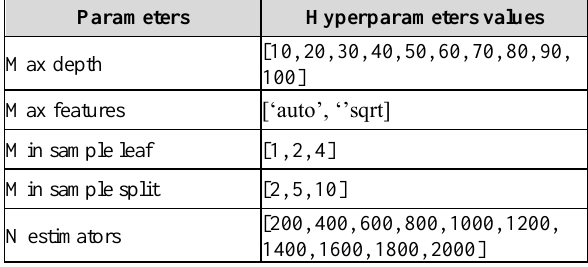
Table 2 . Settings for Hyperparameter Values as Input to the